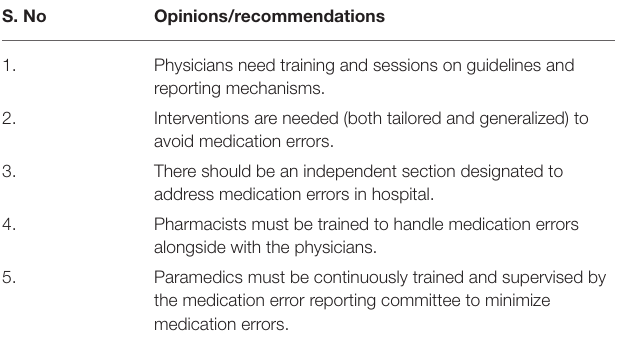
TABLE 2 | Physicians’ opinions and recommendations toward medication